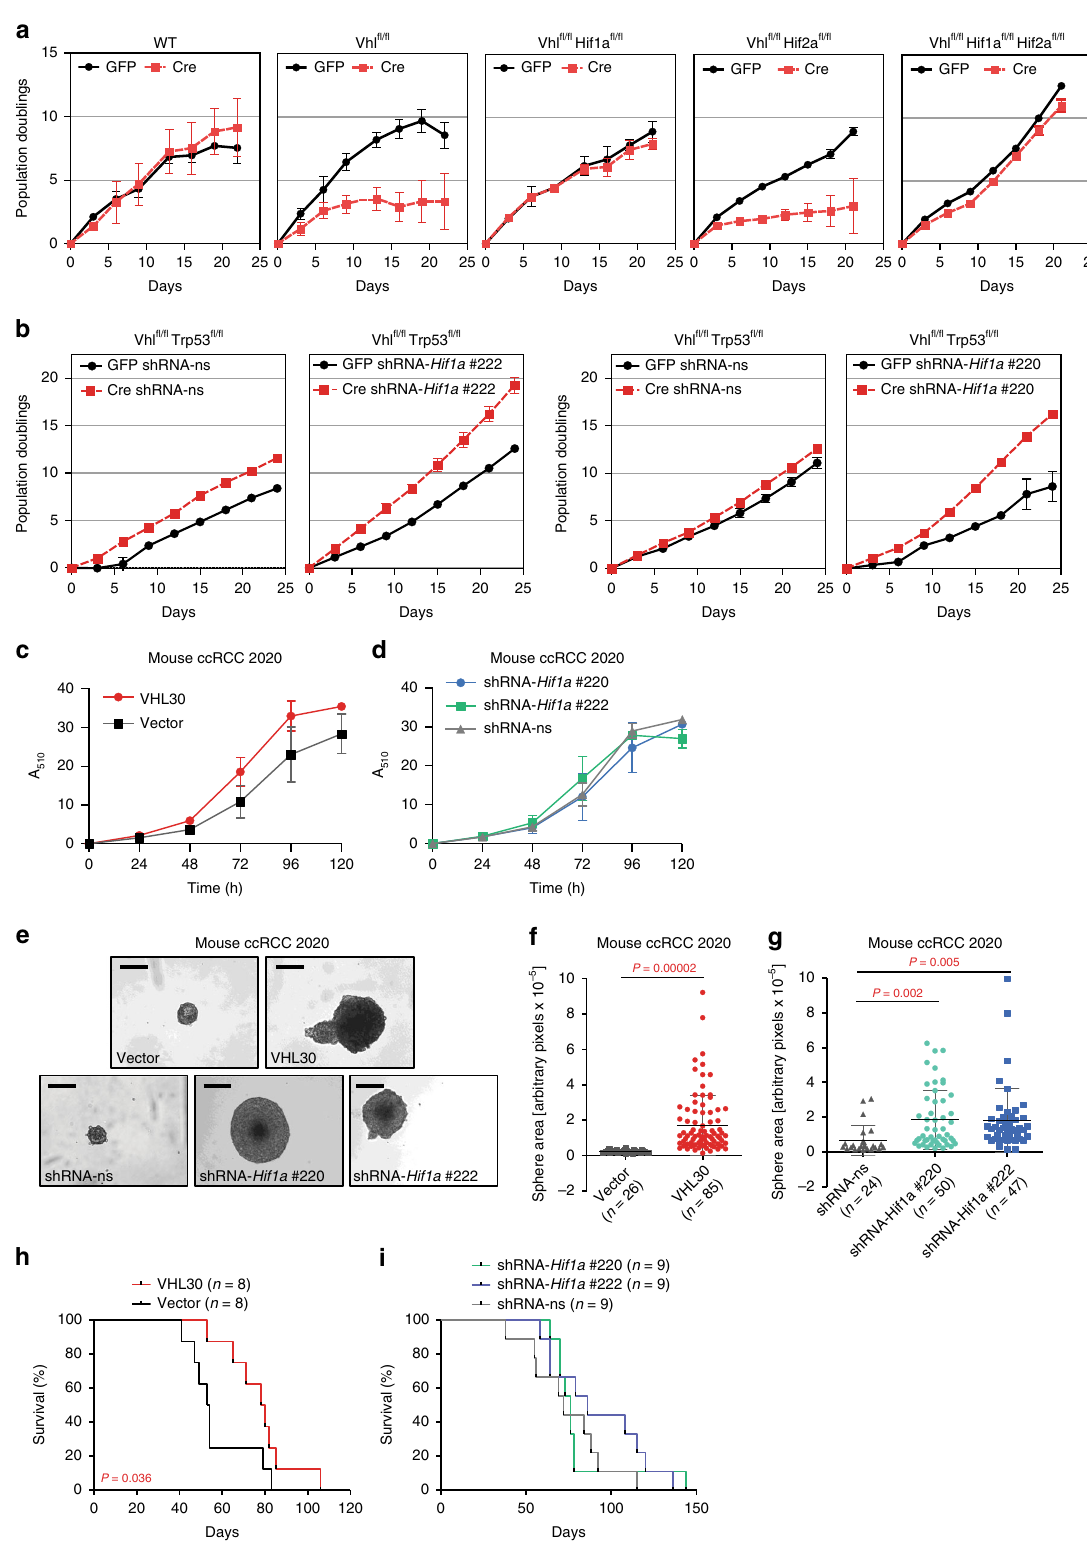
recombination repair, Ogg1 — oxidative stress induced base excision repair, Ercc2 — transcription coupled nucleotide excision repair) (Fig. 3e), cholesterol uptake and lipoprotein metabolism (Fig. 3f), which may relate to the observed dependency of the clear cell phenotype on HIF-2 α , and ribosome biogenesis (Fig. 3g),